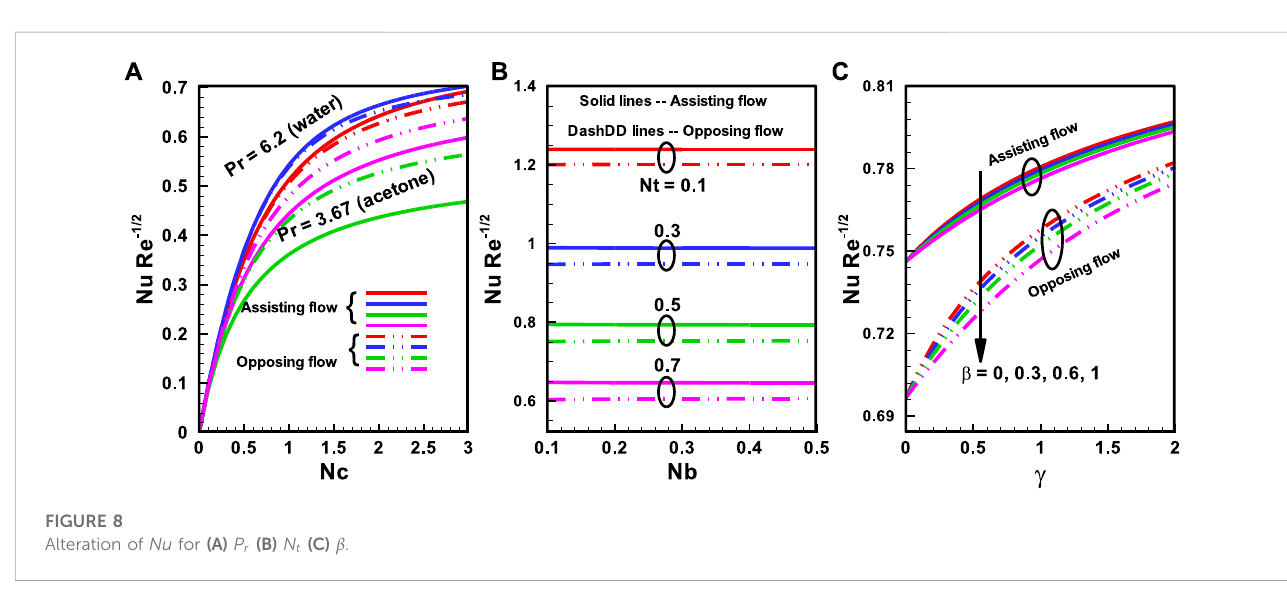
FIGURE 8 Alteration of Nu for (A) P r (B) N t (C) β .